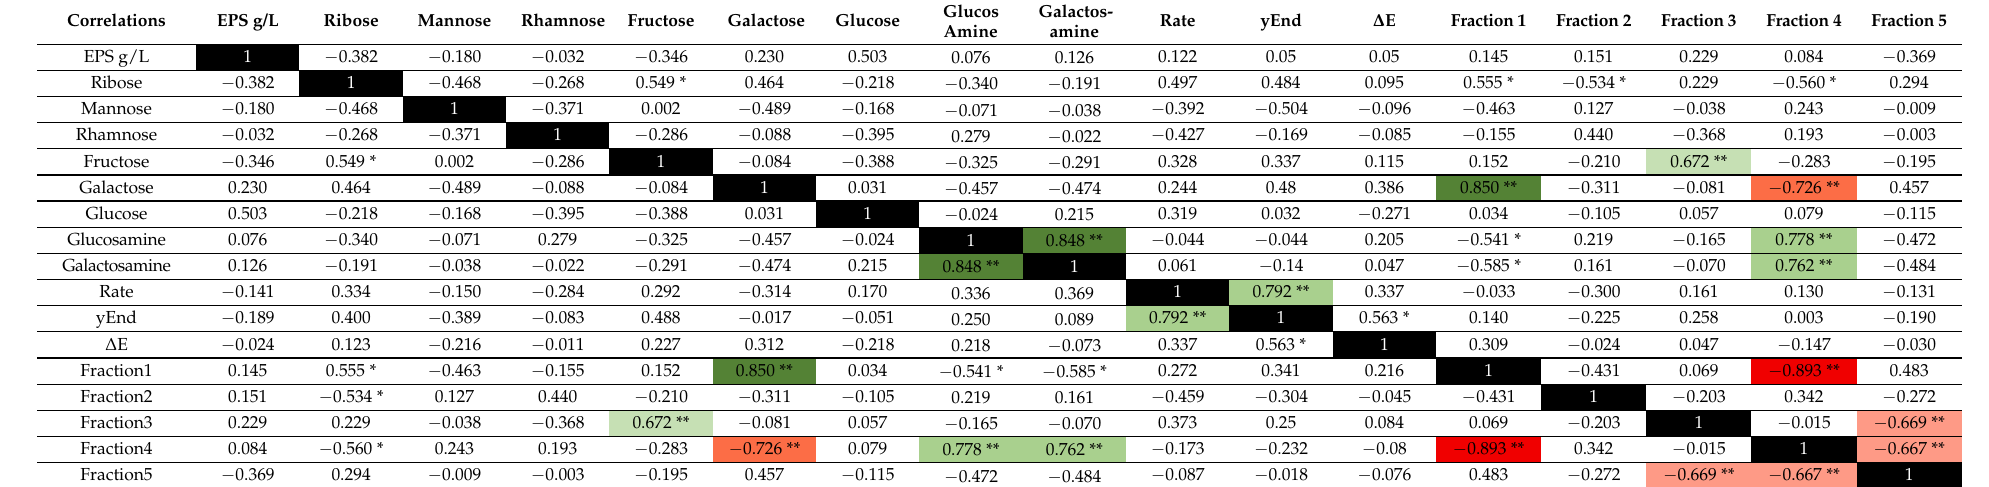
Table 3. Correlation matrix of factors involved in EPS production and